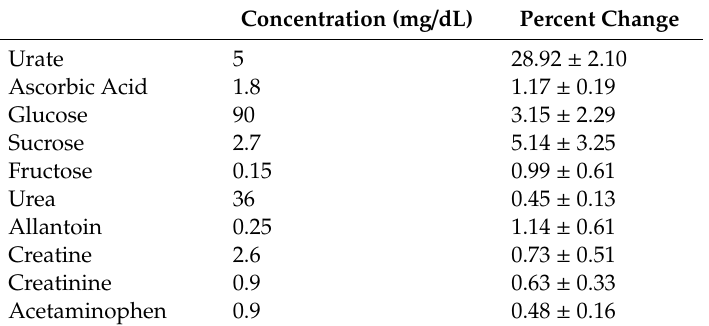
Table 4. Selectivity of urate